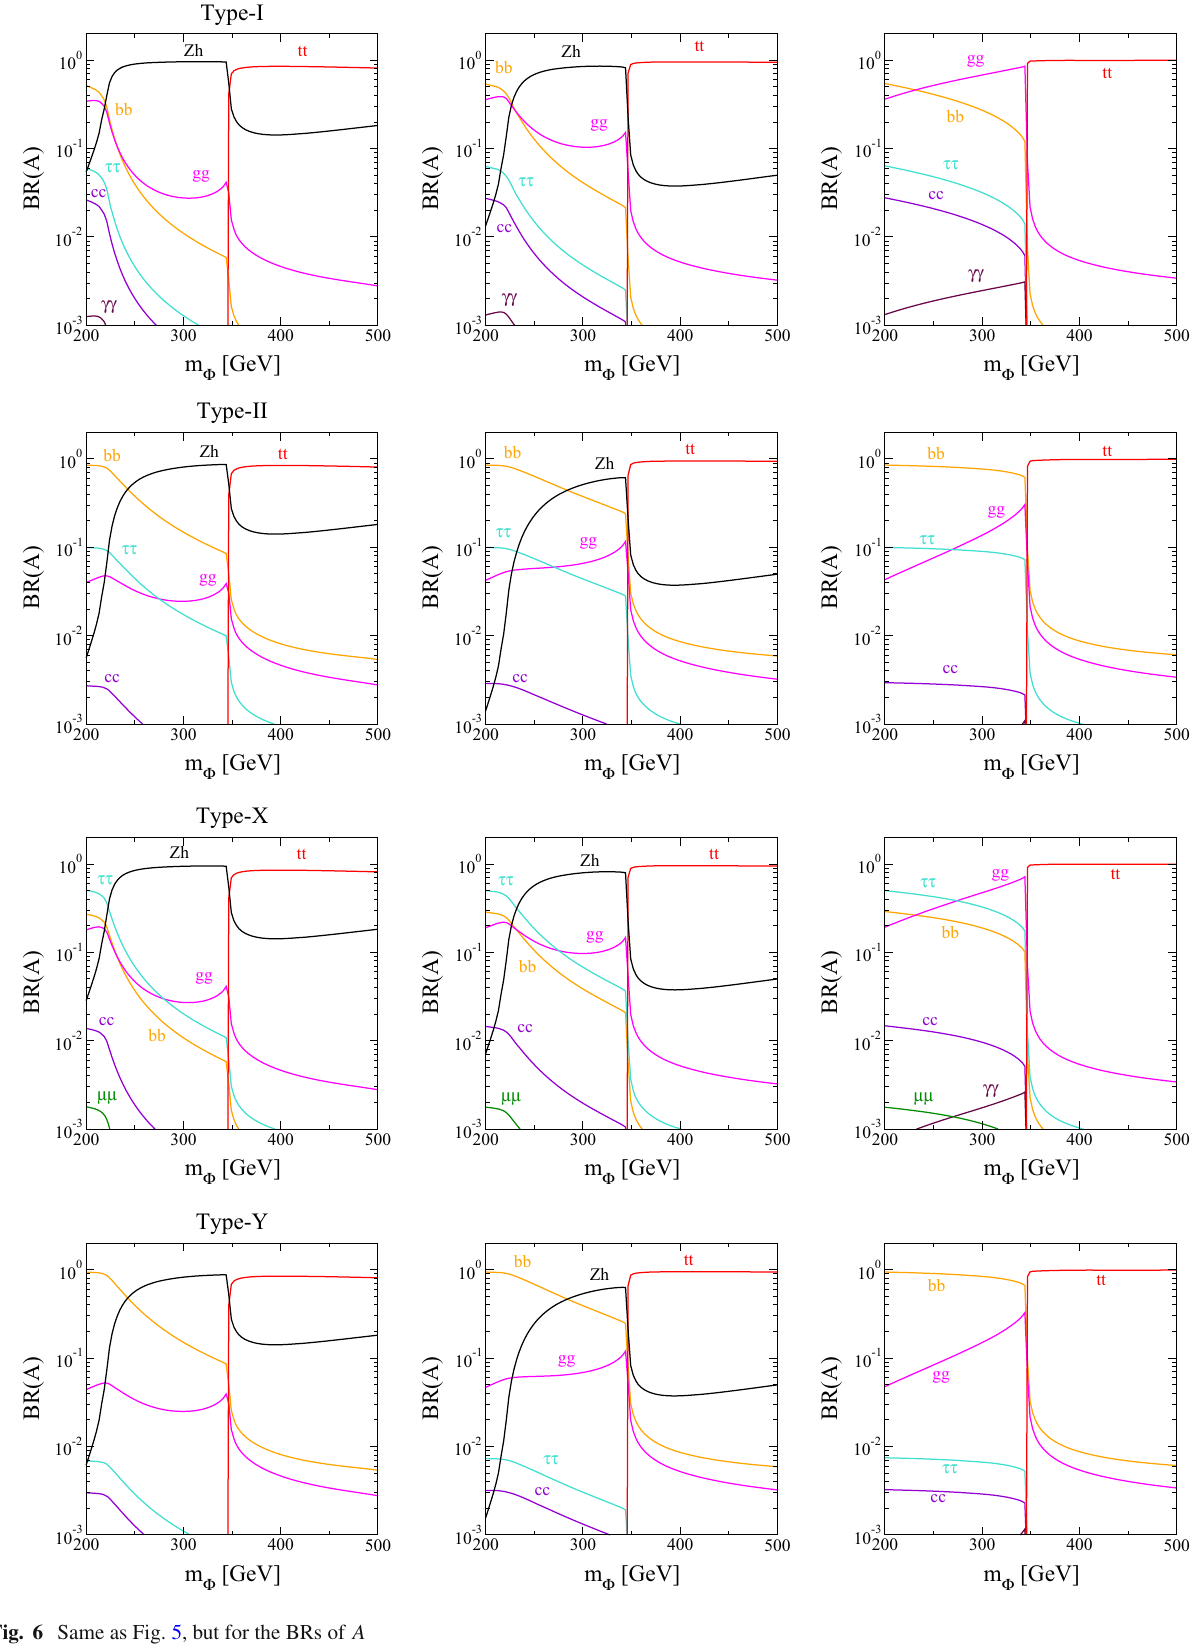
Fig. 6 Same as Fig. 5, but for the BRs of